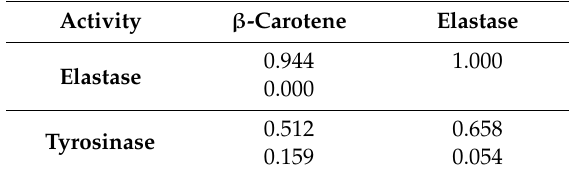
Table 5. Pearson’s correlation among β -carotene bleaching, elastase, and tyrosinase inhibitory activities of MA and